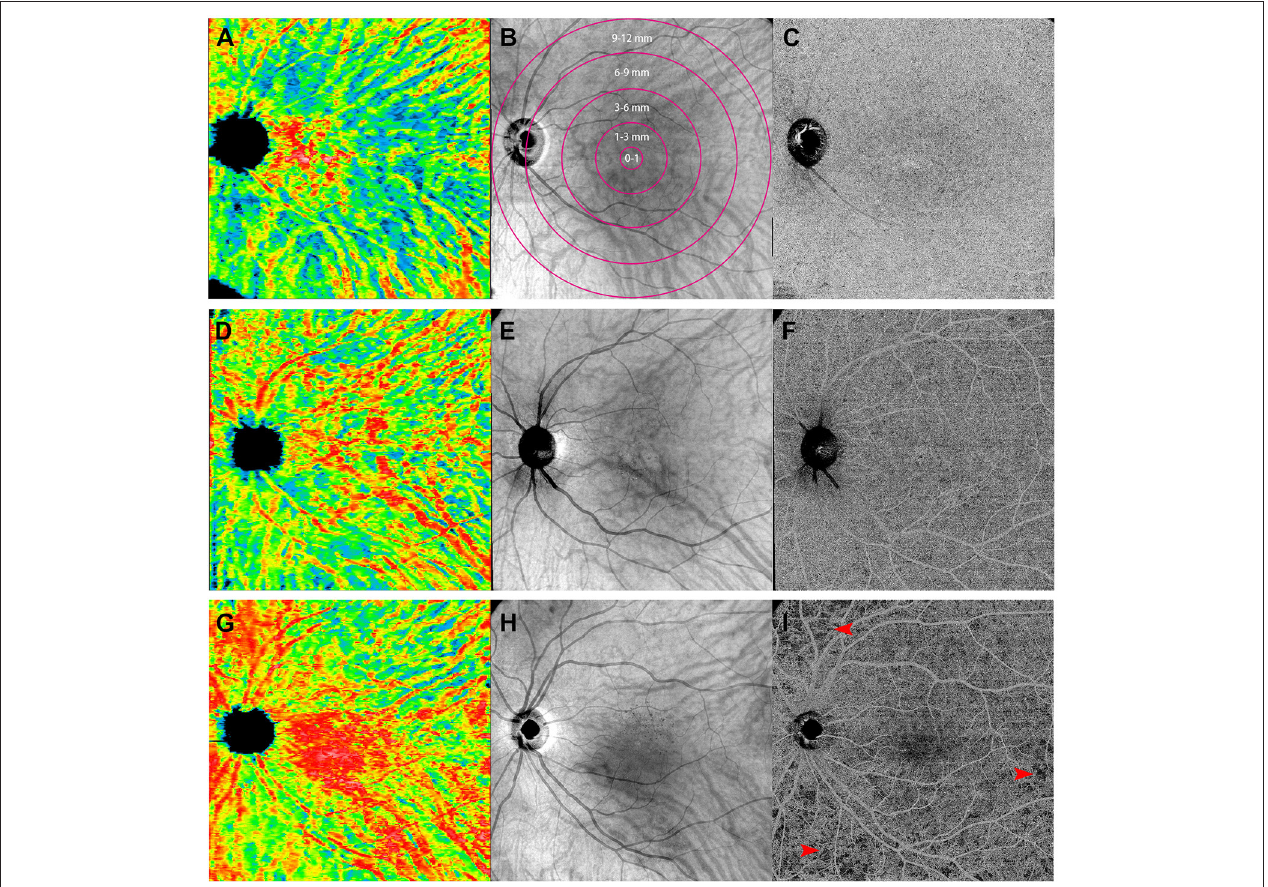
FIGURE 3 | Representative of 12mm × 12mm three-dimensional choroidal vascularity index (CVI) maps (left: A,D,G ), en face images at the level of choroid (middle: B,E,H ), and the swept-source optical coherence tomography angiography (SS-OCTA) scans at the level of choriocapillaris (right: C,F,I ) obtained from the left eye of a sex- and age-matched control (first row: A,B,C ), an inactive Vogt-Koyanagi-Harada (VKH) patient (second row: D,E,F ), and an active VKH patient (third row: G,H,I ). The maps of three-dimensional CVI shows that as compared to the healthy eye (A) , choroidal vessels mildly dilated in the inactive VKH eye (D) , whereas significantly dilated in the active VKH eye (G) , especially in the central region. The OCTA image from a representative active VKH subject (I) shows multifocal flow void which were widespread in distribution and variably size at the level of choriocapillaris layer (red